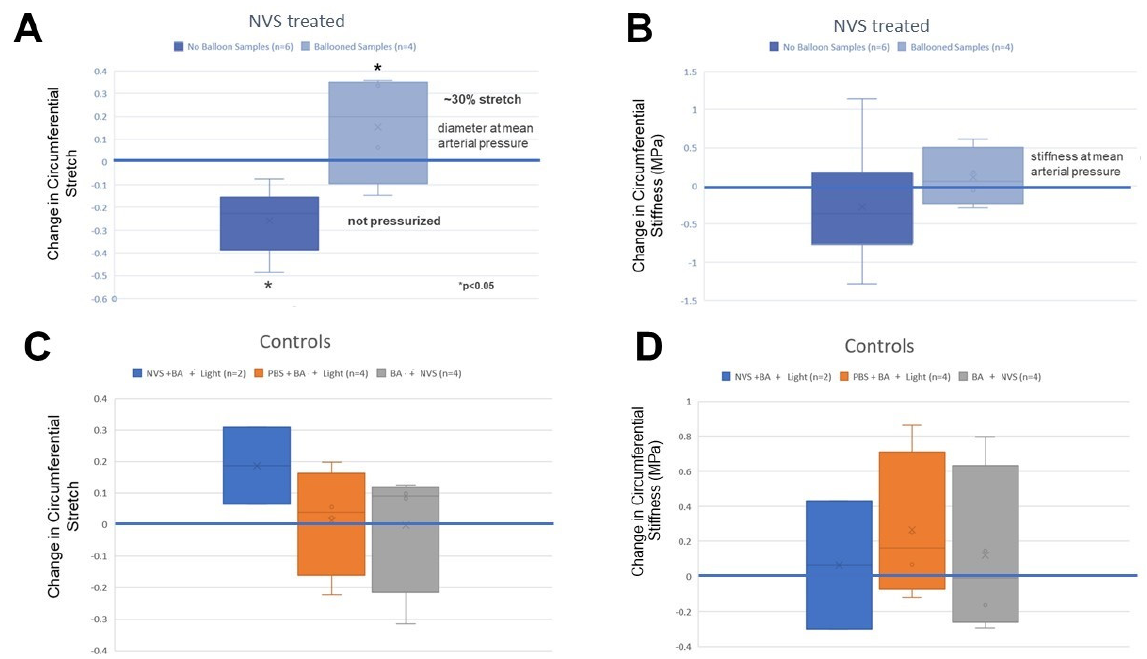
Figure 7. NVS treatment effect on vessel diameter ( A ) and vessel stiffness ( B ) with their respective control studies performed with the balloon-treated arteries (Panels ( C ) and ( D )). The full treatment was compared to balloon and light or balloon and 10-8-10 Dimer treatment